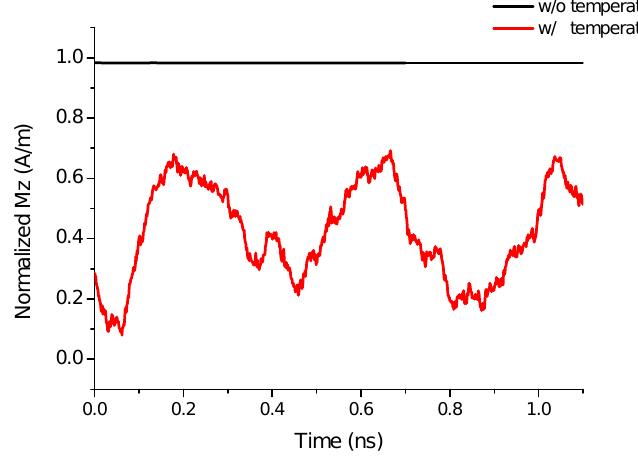
Figure 11. Magnetization on Z-direction (Mz) over time obtained via numerical